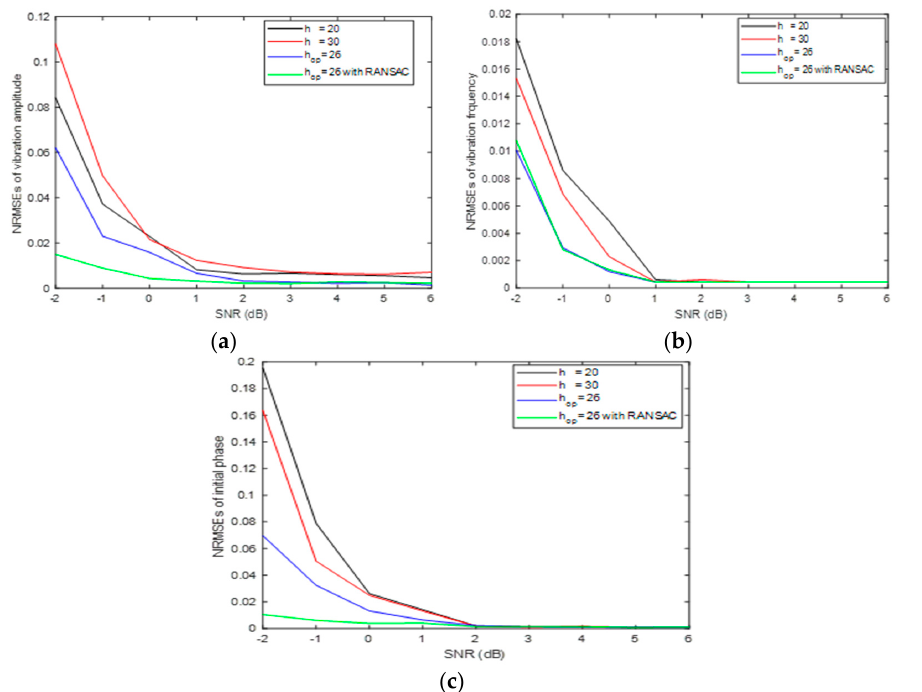
Figure 3. The estimation accuracy of signal parameters for different estimation methods. ( a ) vibration amplitude a 1 . ( b ) vibration frequency f 1 . ( c ) initial phase φ 1